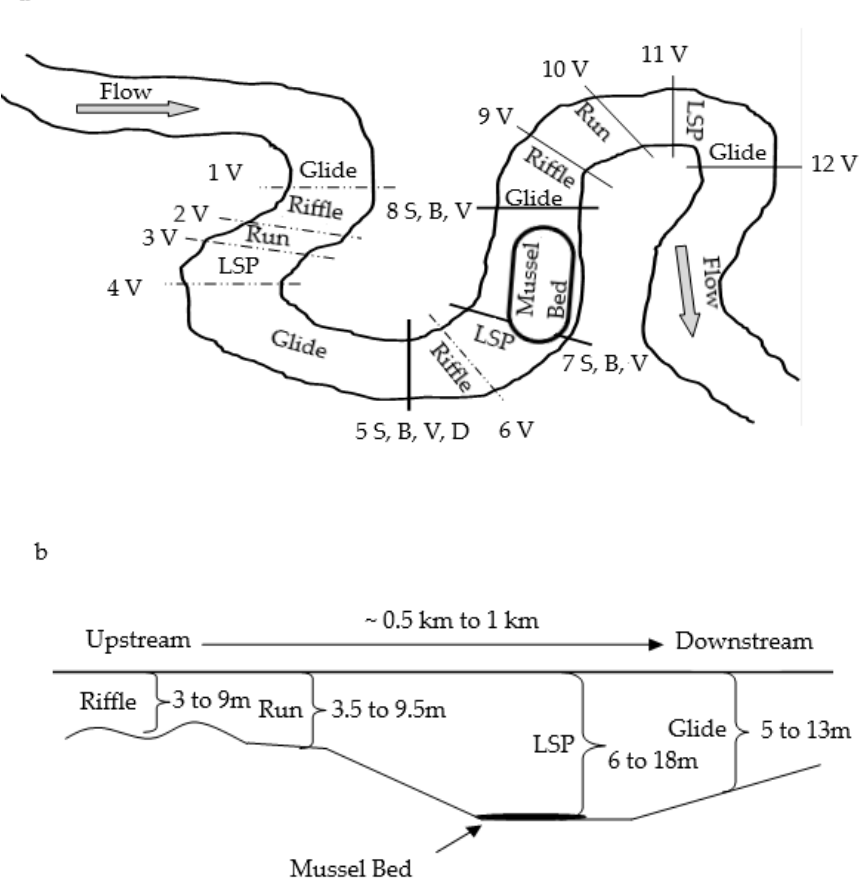
Figure 1. Theoretical schematic of typical mussel bed locations in large alluvial streams of Arkansas [36] and associated reach scale habitats (e.g., ri ffl e, run, lateral scour pool (LSP), and glide) and sampling locations. ( a ) Overhead planform view of the hypothetical habitat / sampling transect distribution within a study reach indicating type of sample collected (discharge (D), velocity profile (V), bedload (B), suspended sediment (S)). Primary transects indicated by solid, bold lines, secondary transects by fine, solid lines, and tertiary transects by dashed lines. ( b ) A longitudinal cross-section showing the vertical profile of sampled habitats with corresponding thalweg depth ranges over all three sampling events. Illustration created by